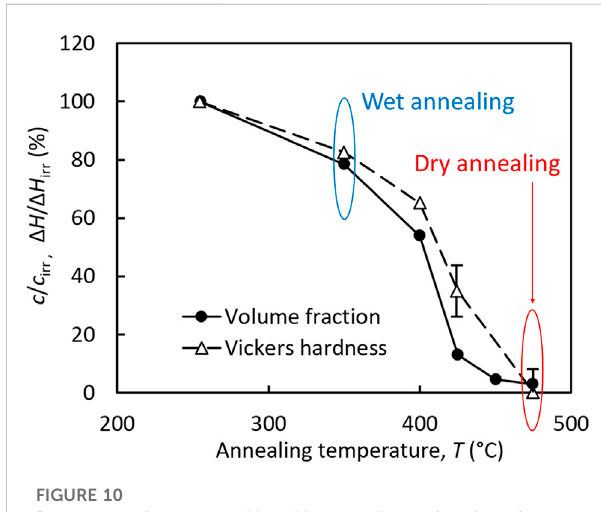
FIGURE 10 Percentage of recovery achieved by annealing as function of annealing temperature. Temperatures of interest for technical purposes related to wet and dry annealing are